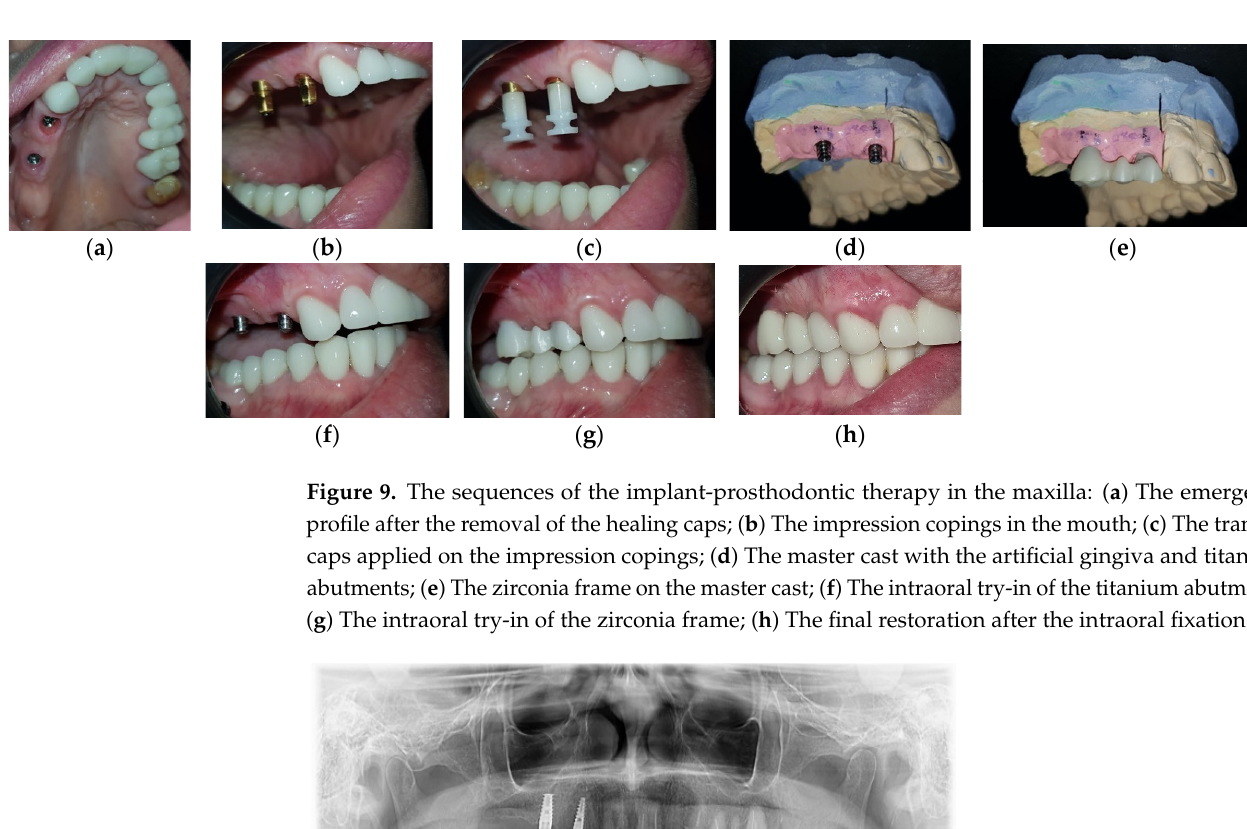
Figure 10. Panoramic X-ray with the osseointegrated implants on the lower arch and the good marginal adaptation of all the restorations.